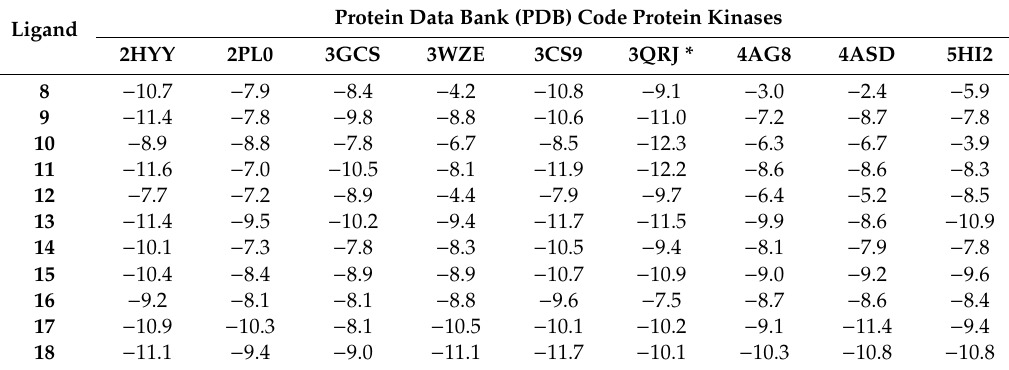
Table 3. Inhibition of receptor tyrosine kinases by compounds 5 , 10 , 11 , 13 – 15 , 17 , 18 , 20 , 22 – 24 , 28i – 28l , and imatinib.